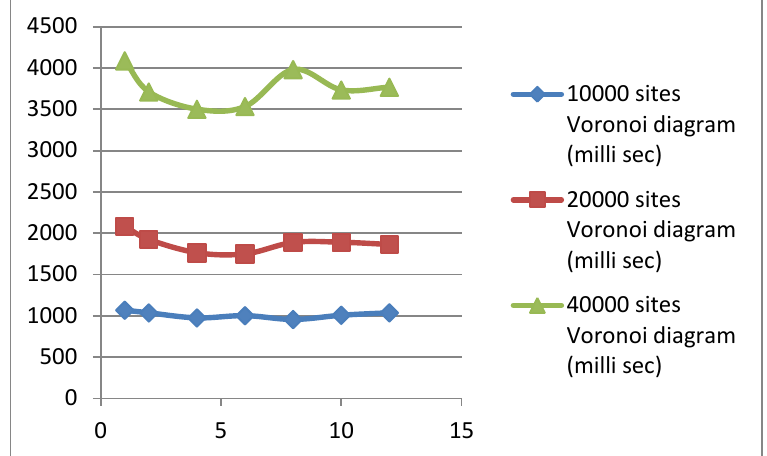
Figure 6. The execution time of Triangulation refinement of three Voronoi diagrams generated from 10,000, 20,000, and 40,000 sites, respectively, using 1 to 12 parallel